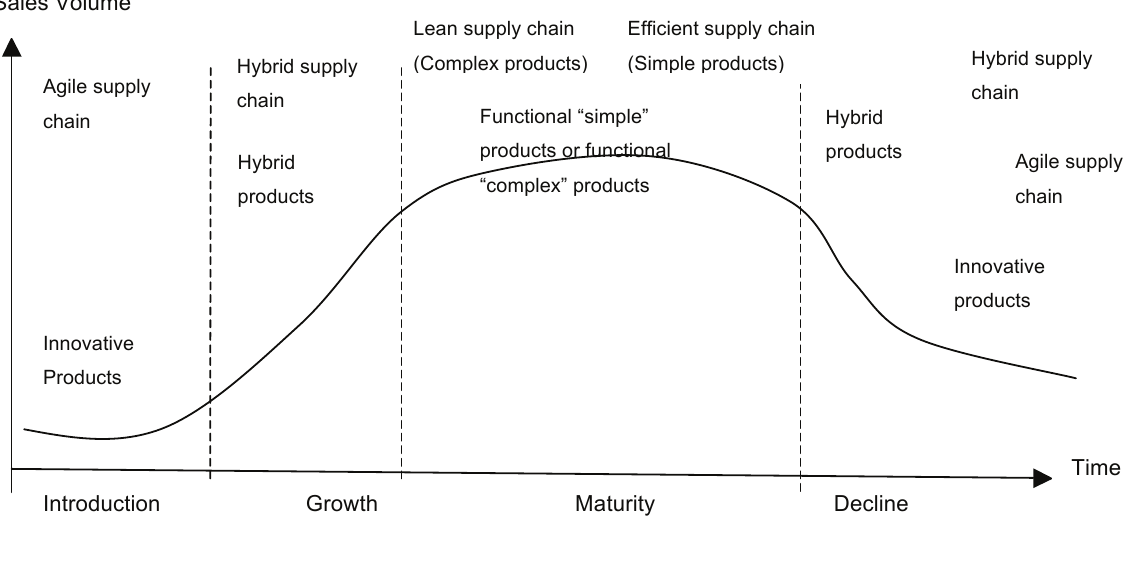
Figure 1: Supply chain strategies linked to the product life cycle Source: Chibba (2007); Astrom and Ohgren (2010:22); Qi et al. (2009:670)